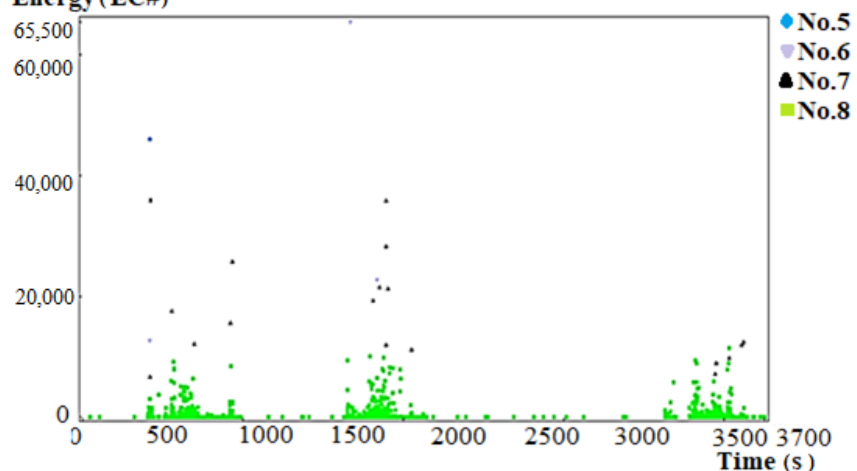
Figure 14. AE signal energy as a function of time for the gas pipeline with the numbers of signal classes marked. Appl. Sci. 2018 , 8 , x